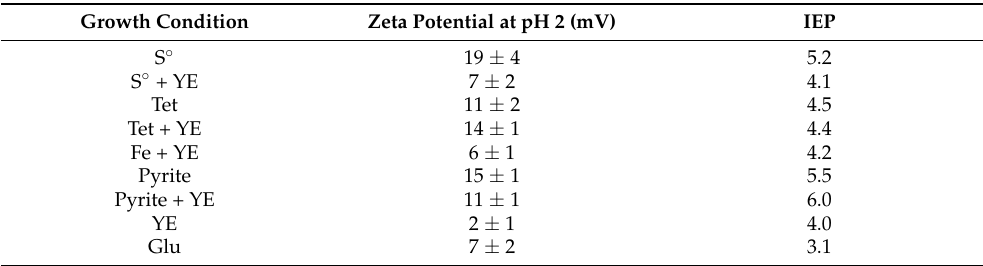
Table 1. Zeta potential measurements at pH 2 and IEP values of A. copahuensis cultured in different growth